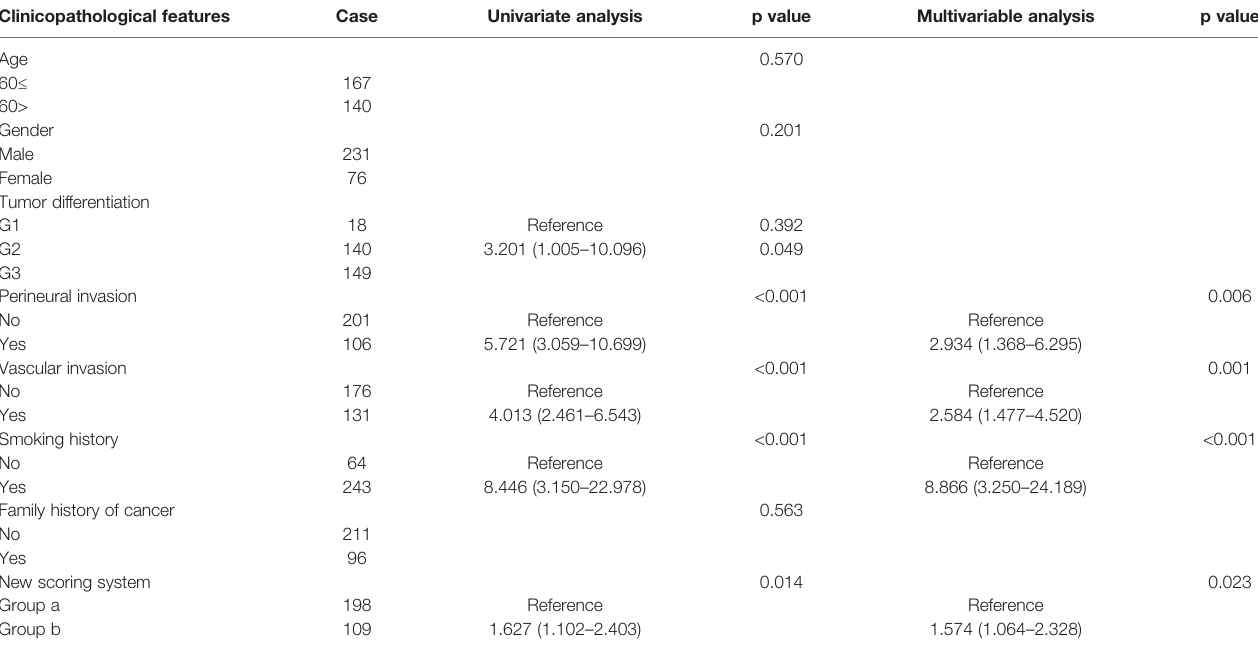
TABLE 2 | Univariate analysis and multivariable analysis of clinicopathologic variables in relation to OS. Clinicopathological features